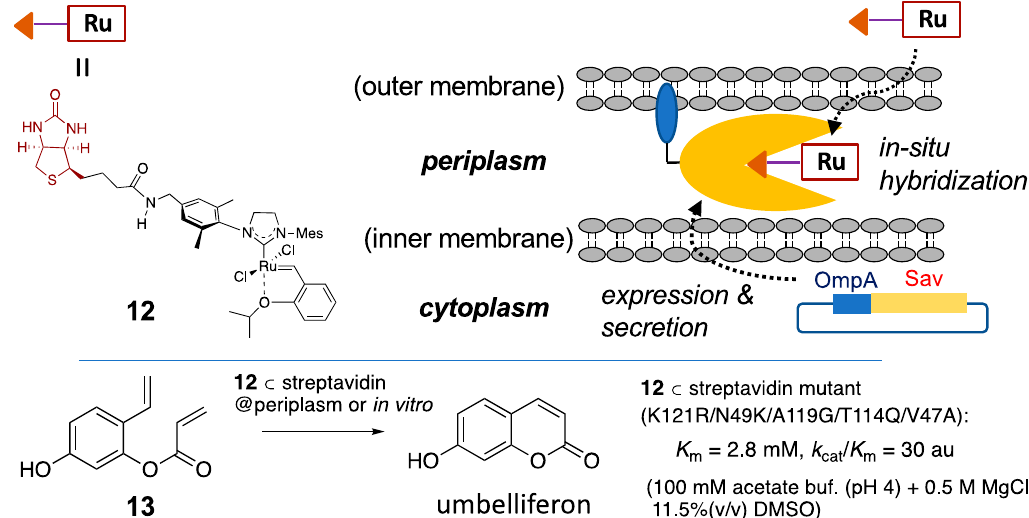
Figure 6. In-situ preparation of the hybrid OM-ArM composed of OmpA-fused streptavidin and complex 12 in periplasm of E. coli cells [38]. In the figure, “Sav” stands for “streptavidin”.